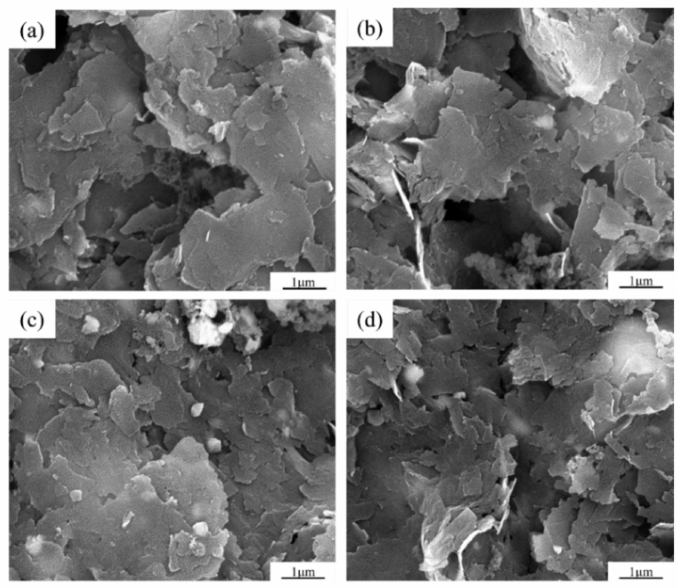
Figure 3. 10 SEM photos of graphene after different ball milling time. ( a ) 1 h, ( b ) 2 h, ( c ) 5 h, ( d ) 10 h.